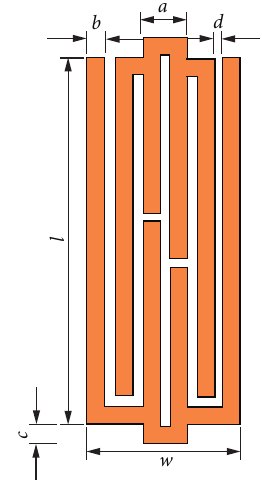
Figure 1: Structure of the designed LHM